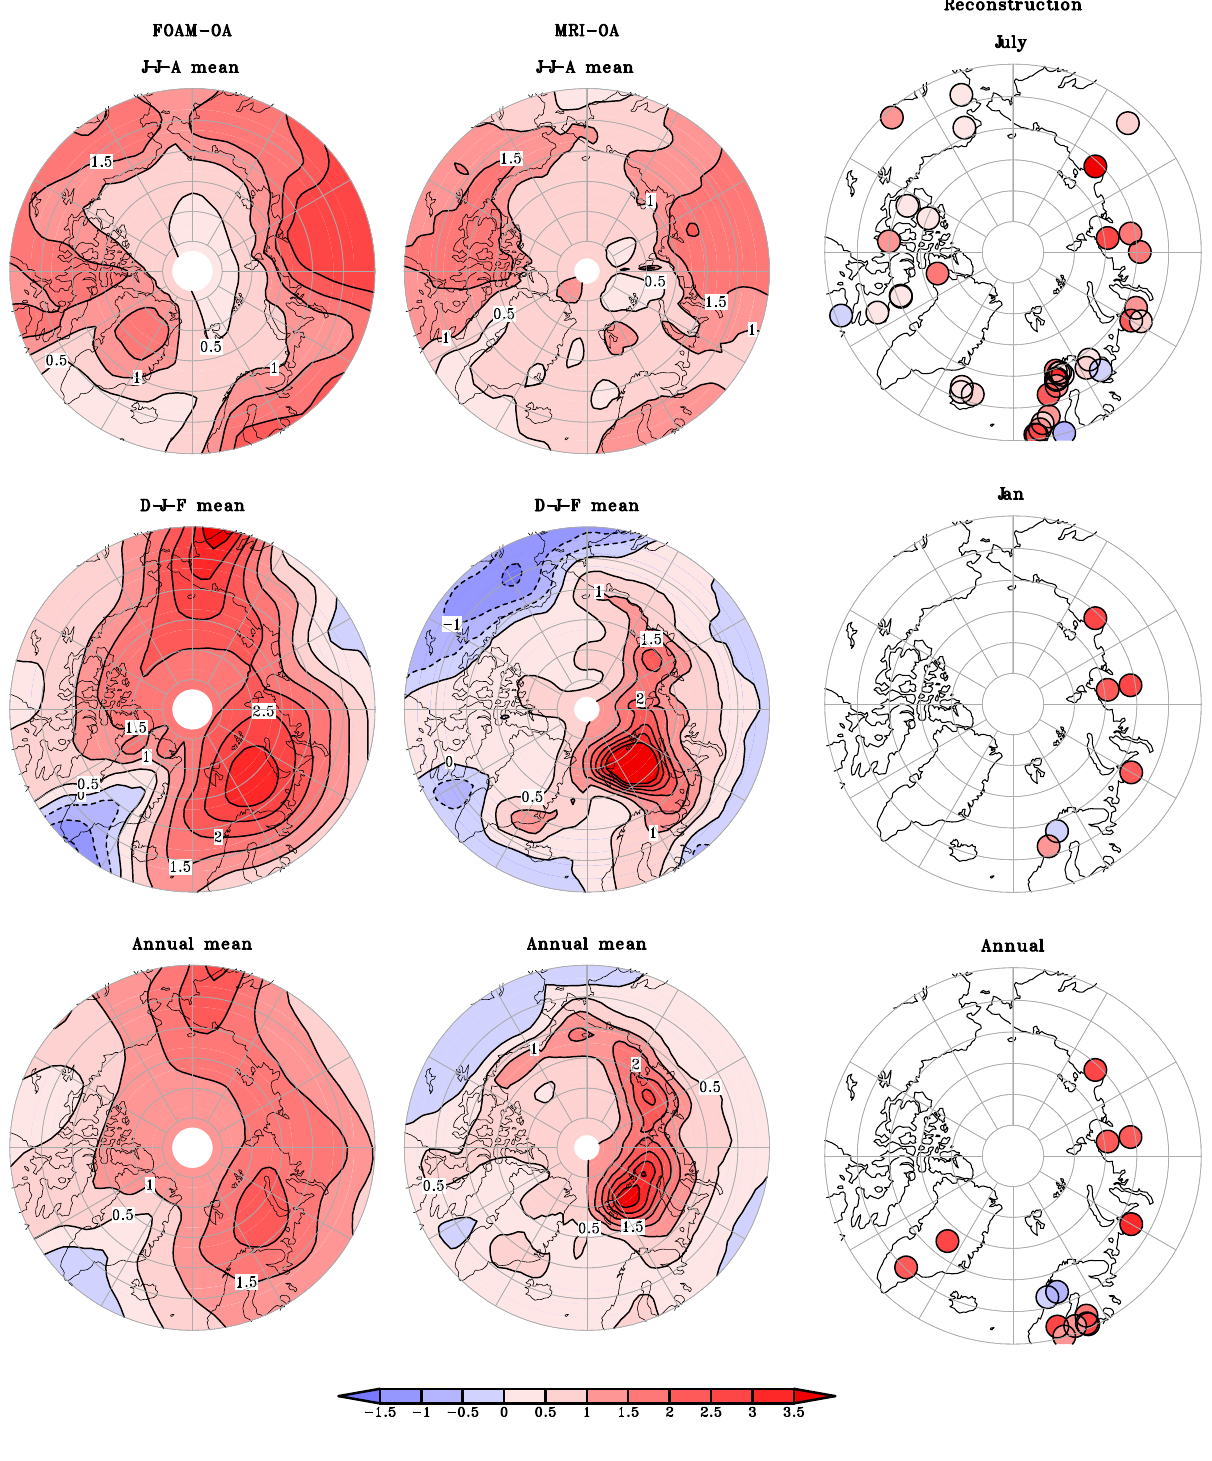
Fig. 6. Large scale pattern in surface temperature ( ◦ C) change in FOAM-OA (left column), MRI-OA (middle column), and reconstructions (right column). Top row is for summer temperature, represented by JJA mean for model data and July and August temperature for reconstruc- tions; middle row is for winter temperature, represented by DJF mean for model data and January temperature for reconstructions; bottom row is for annual mean temperature.